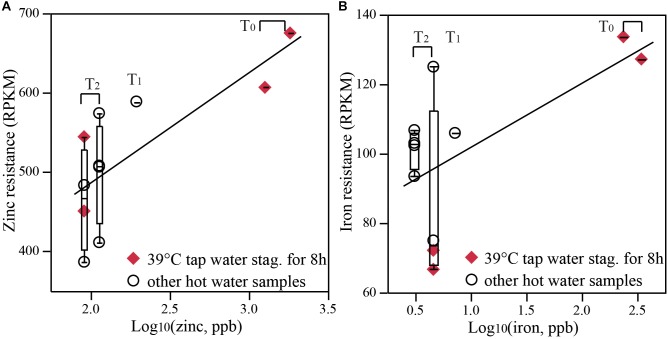
The abundance of metal resistance genes correlated with metal concentration. Normalized abundance of (A) zinc and (B) iron resistance genes (RPKM, reads per kilobase of transcript per million) in hot water samples correlated positively with zinc and iron levels, respectively, which reduced from T0 to T2. All distal tap waters and recirculating water from the same rig at the same time point were grouped together for correlation analysis. Correlation coefficient equals to 0.61–0.76, p < 0.0001. Distal tap water from both rigs operated at 39°C with a stagnation period of 8 h were labeled as diamonds to emphasize solely temporal change.